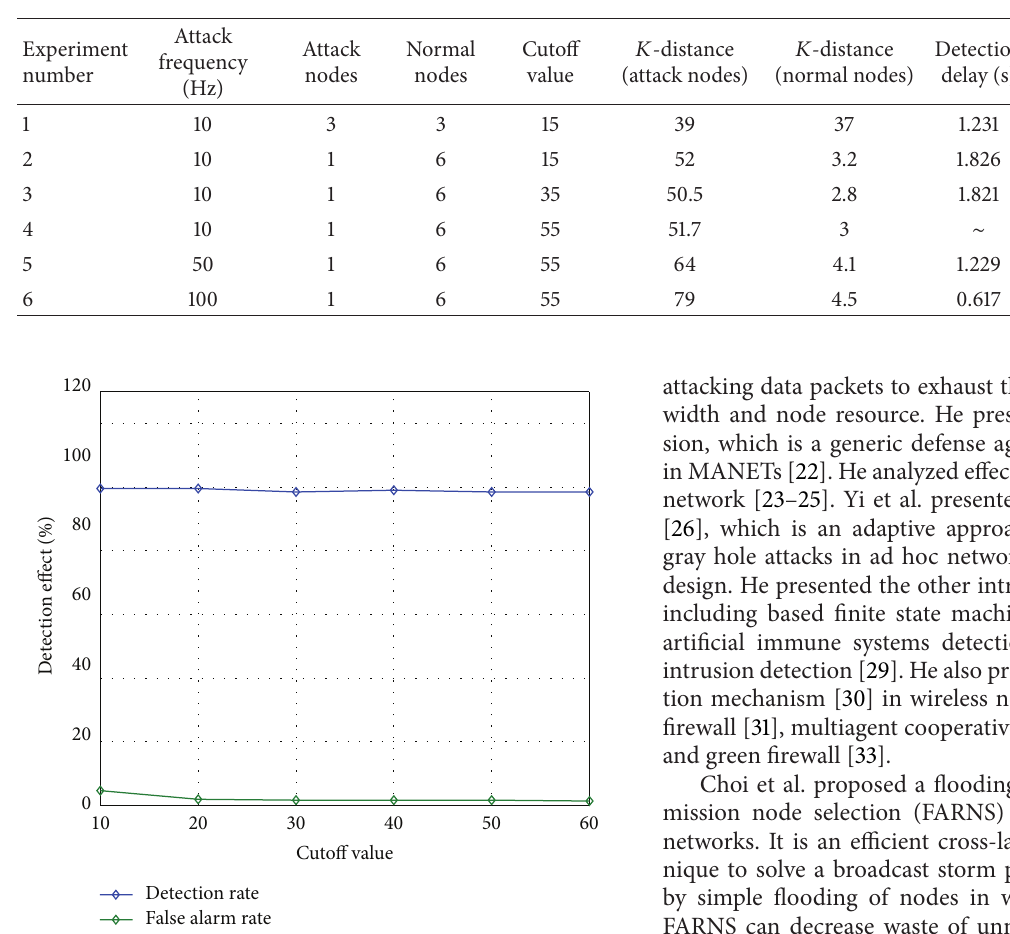
Table 1: The experiment data of average value under detection.